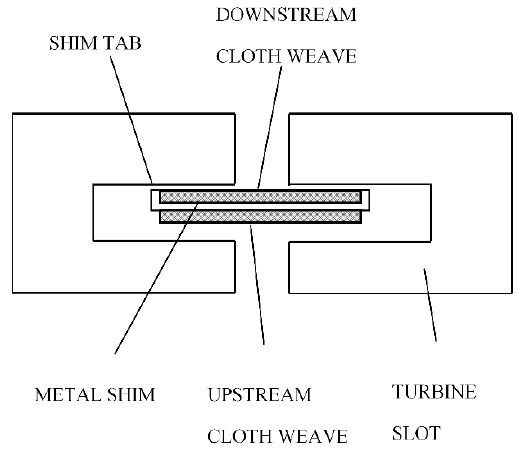
Figure 3. Schematic of the cloth seal integration.